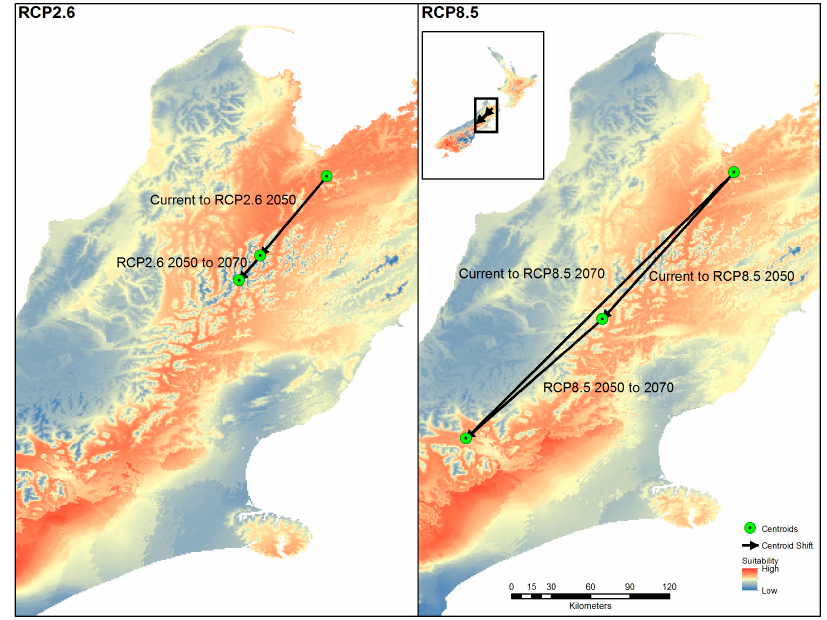
Figure 6. Centroid shift for Representative Concentration Pathways (RCP) 2.5 and RCP 8.5 from current times to the years 2050 and 2070 using the centroid of reclassified High suitability category areas.